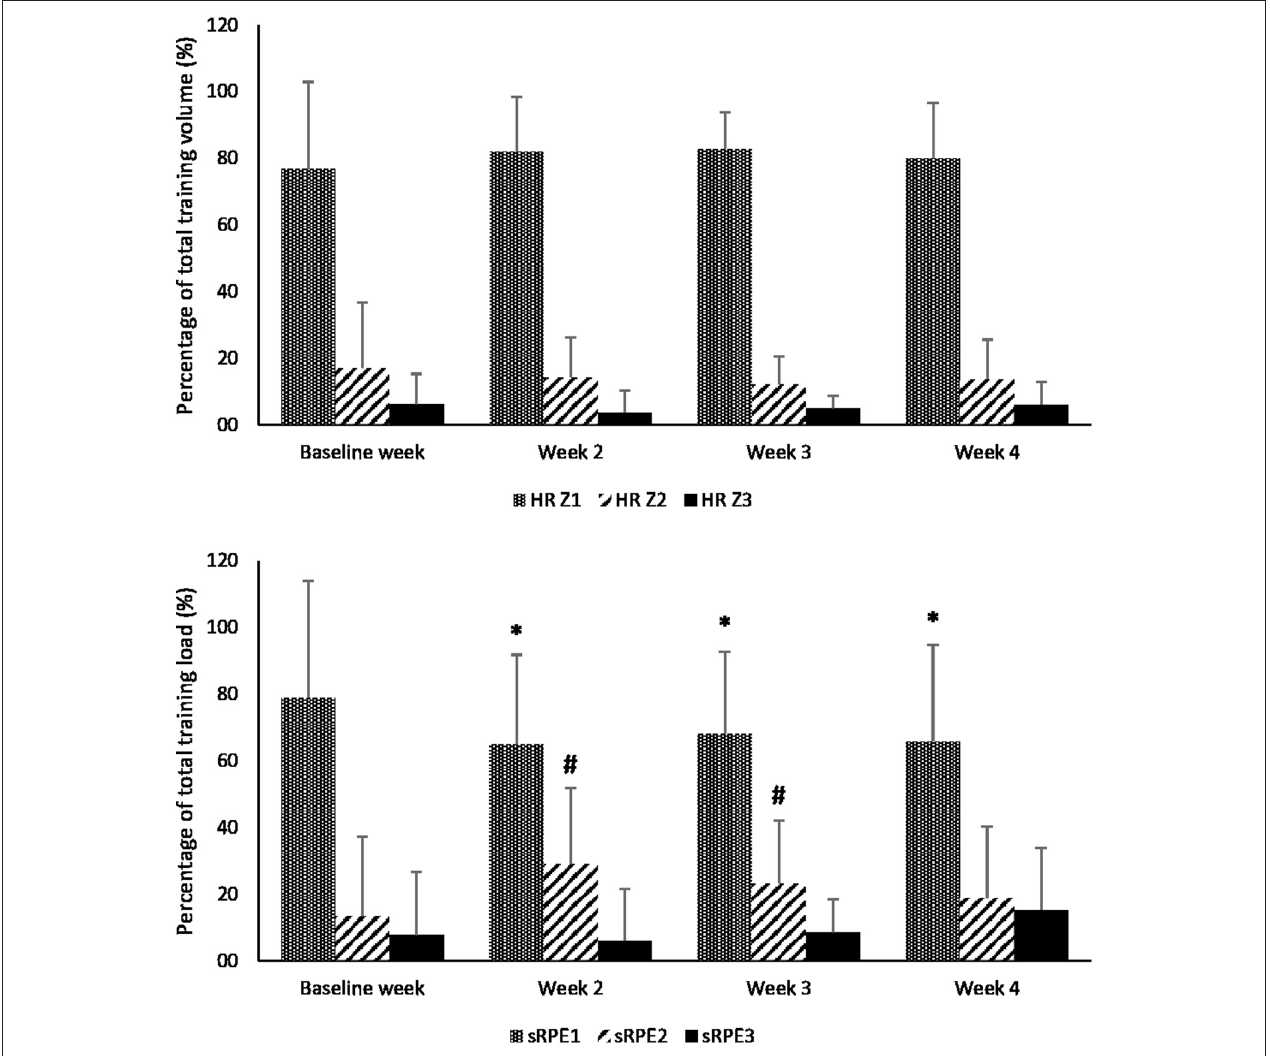
FIGURE 2 | Differences between the percentages (%) in heart rate zone distributions (i.e., HR Z1, HR Z2, and HR Z3; upper panel) and the respective effort-based zone distributions (i.e., sRPE1, sRPE2, and sRPE3; lower panel) during the 4-week training period; *Significantly different from HR Z1 p < 0.05; #Significantly different from HR Z2 ( p <